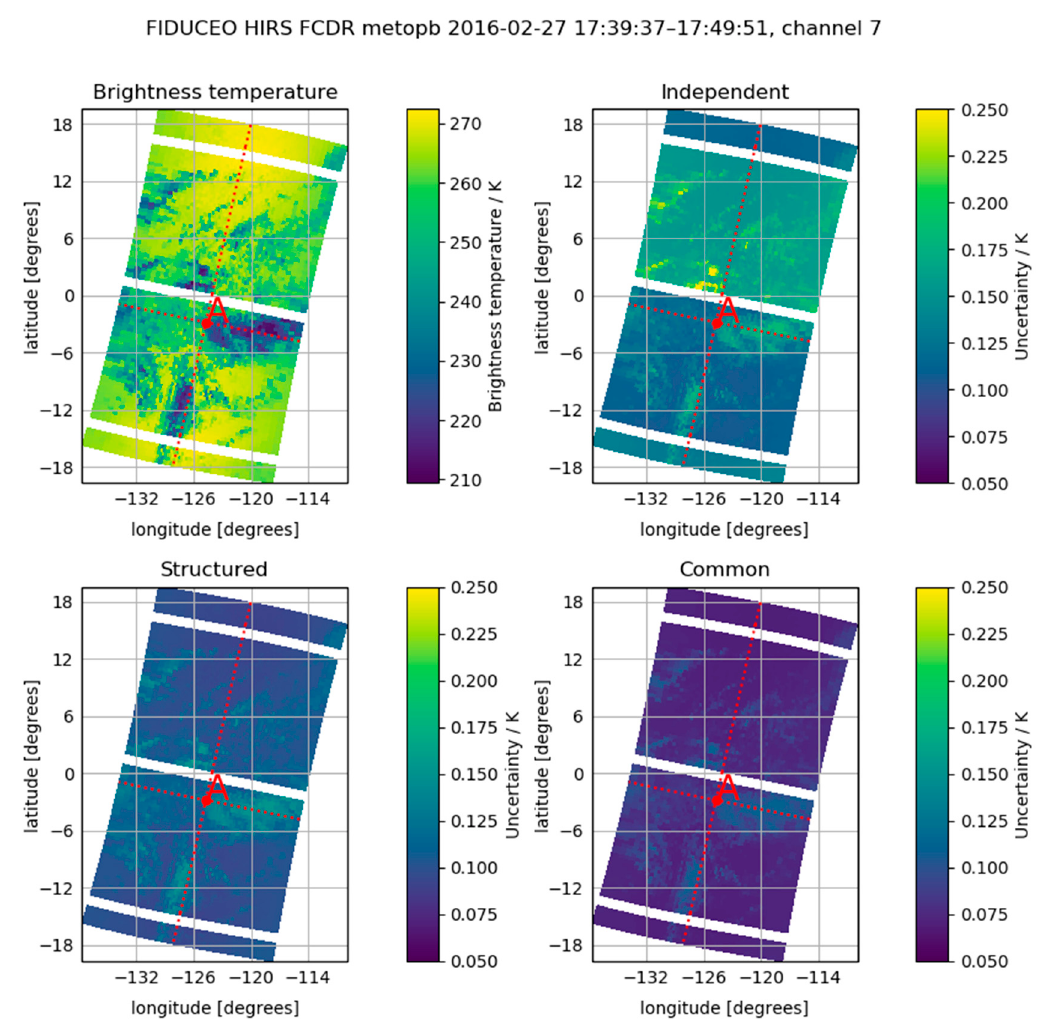
Figure 1. Top left: Brightness temperature image raster of an extract between 17:39:73 and 17:49:51 UTC of HIRS channel 7 on Metop-A. Top right, and lower row: the corresponding fields of standard uncertainty in brightness temperature arising from independent, structured and common errors. The red square labelled ‘A’ indicates a specific pixel and the dashed lines the position of the scan and element arrays through ‘A’. The imagery is taken from a descending pass.